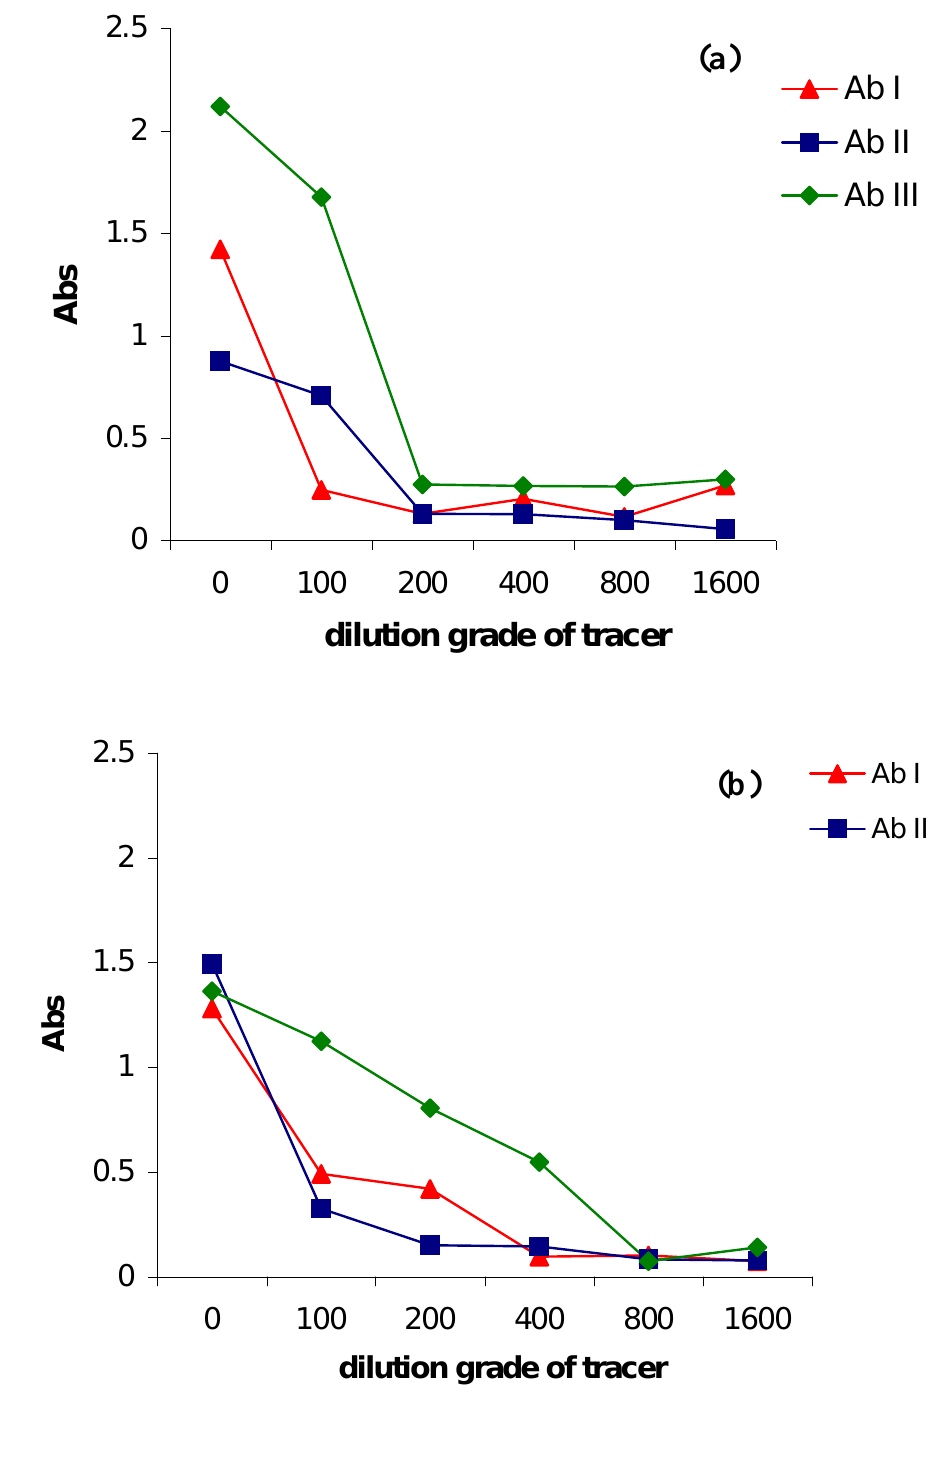
Figure 1. Dilution curve of tracer in the case of ( a) covalent immobilization of antibody on the magnetic particles surface; (b) affinity immobilization of antibody on the magnetic particles surface via protein G; (c) affinity immobilization of antibody on the magnetic particles surface via protein A (1:1000 dilution of antibody-beads